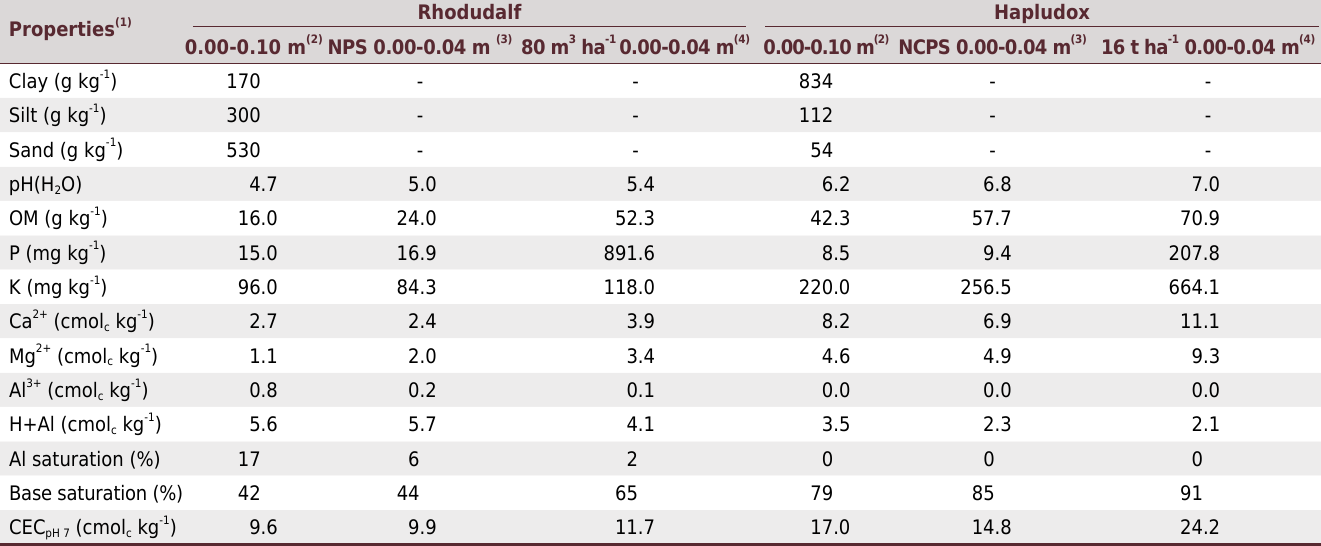
(1) All the properties were analyzed according to Donagema et al. (2011). (2) Samples collected from the 0.00-0.10 m layer before the period of residue applications. (3) Samples with no pig slurry application (NPS) or without wood shavings/pig slurry compost (NCPS), collected from the 0.00-0.04 m layer after the period of residue applications. (4) Samples treated with 80 m 3 ha -1 of pig slurry or 16 Mg ha -1 of wood shavings/pig slurry compost, taken from the 0.00-0.04 m layer after the period of residue